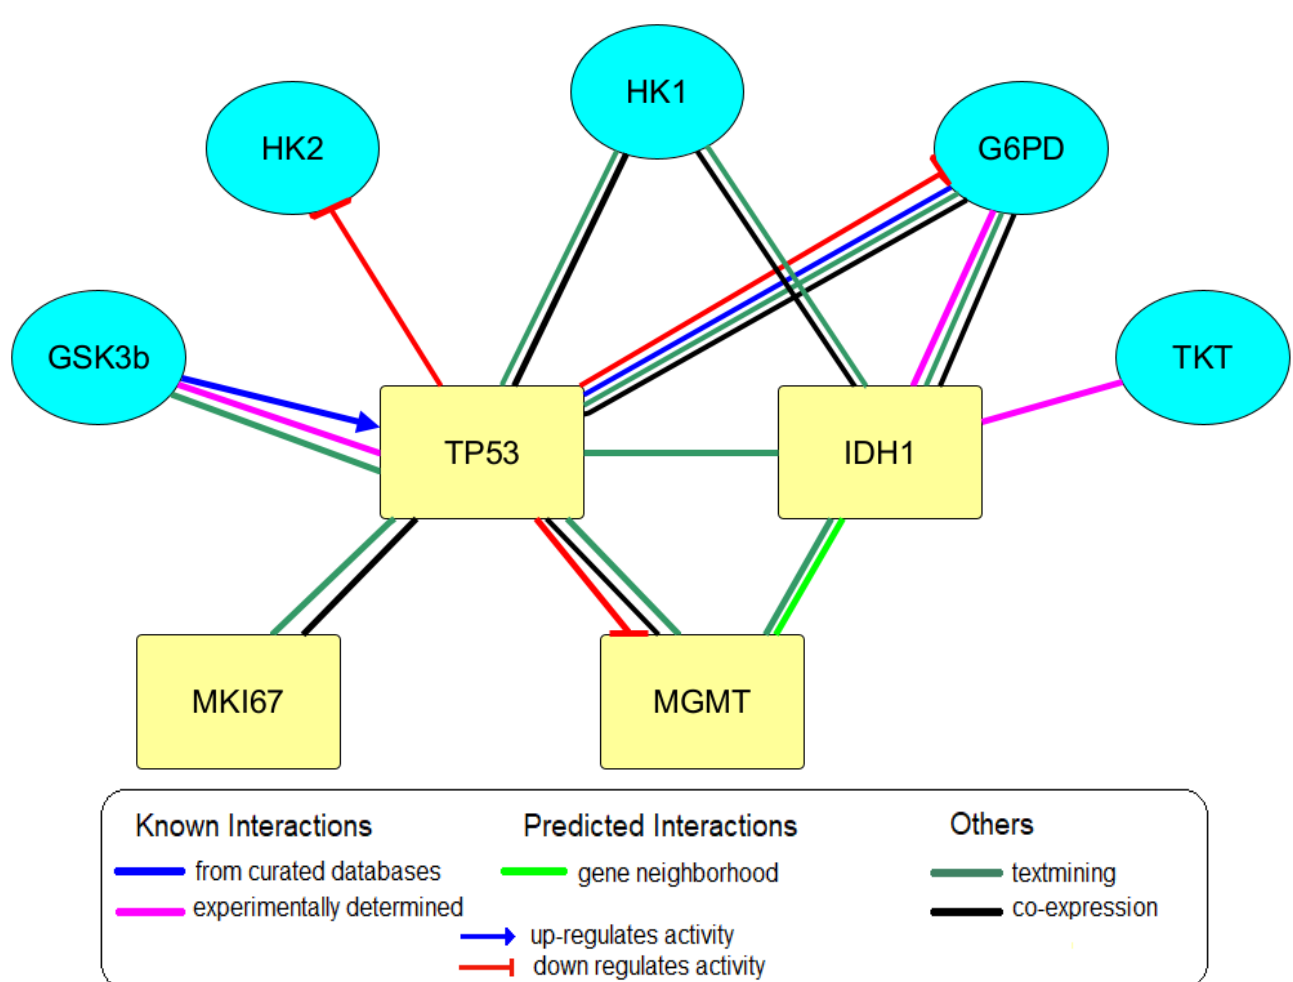
Figure 2. Integral scheme of protein–protein interactions of immunohistochemical tumor markers of gliomas with carbohydrates metabolism according to the databases of BioGrid, String, and Signor using the yEd Graph Editor program. Legend: GSK3B—glycogen synthase kinase 3 beta; TKT —